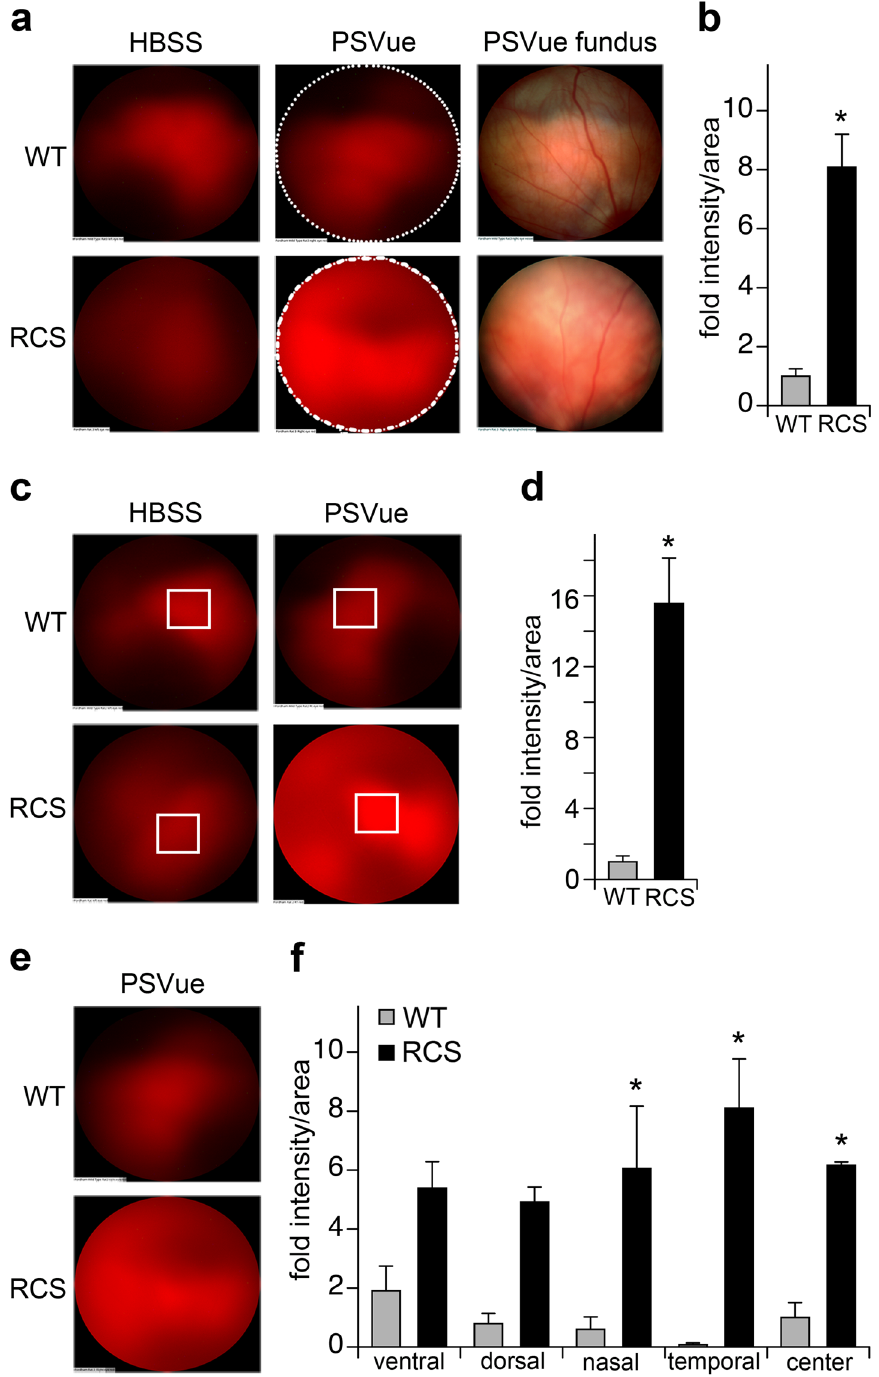
Figure 3. Live imaging of apoptotic photoreceptors in vivo by retinal imaging. ( a ) Representative fluorescence images of photoreceptors and fundus images of p25 RCS and WT rats 24 hours after PSVue-550 or HBSS solvent eyedrop application as indicated. ( b ) Quantification of fluorescence intensity after background subtraction in areas indicated by dashed lines. * P < 0.05 by Student’s t -test. ( c ) Photoreceptor fluorescence and ( d ) quantification as in b of fluorescence intensity maxima. * P < 0.05 Student’s t -test. ( e ) Photoreceptor fluorescence and ( f ) quantification of areas of fluorescent intensities specific to retinal quadrants. * P < 0.05; two-way ANOVA and Tukey post-hoc test. ( b , d , f ) All bars show mean ± SEM, n = 3 animals per